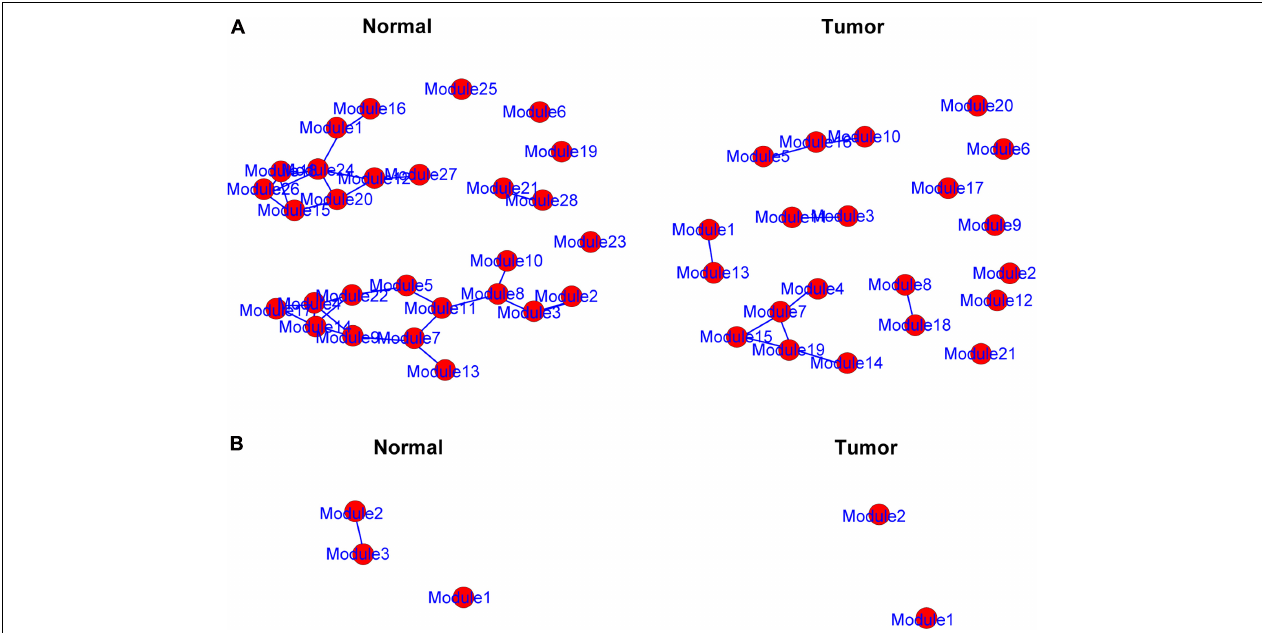
FIGURE 4 | Representation of the module networks. Images of yellow (A) and medium orchid (B) module networks from the TCGA dataset were shown. Each node represented one module, and each edge represented the module